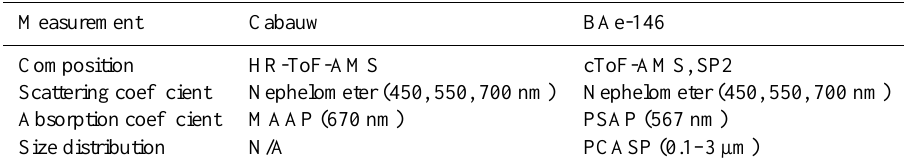
Table 2. Summary of instrumentation from the ground-based site at Cabauw and the BAe-146 aircraft used in this study. Acronyms used are as follows: cToF-AMS (compact Time-of-Flight Aerosol Mass Spectrometer, HR-ToF-AMS (High-Resolution Time-of-Flight Aerosol Mass Spectrometer), Single Particle Soot Photometer (SP2), PSAP (Particle Soot Absorption Photometer), MAAP (Multi-Angle Absorption Photometer) and PCASP (Passive Cavity Aerosol Spectrometer Probe). The wavelengths and size ranges applicable to the optical and physical property measurements are given in